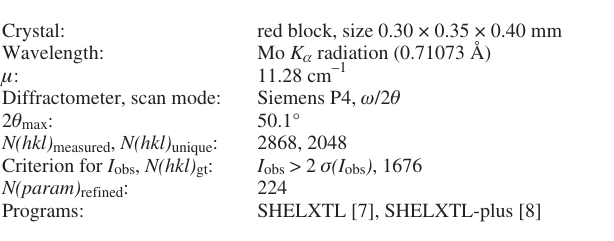
Table 1. Data collection and handling.